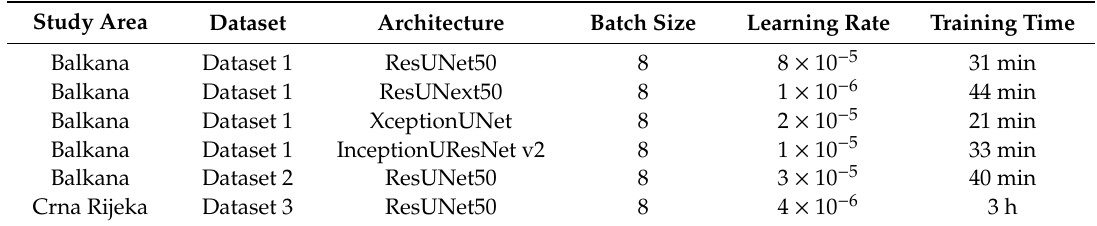
Table 2. Hyperparameters used for training the models.